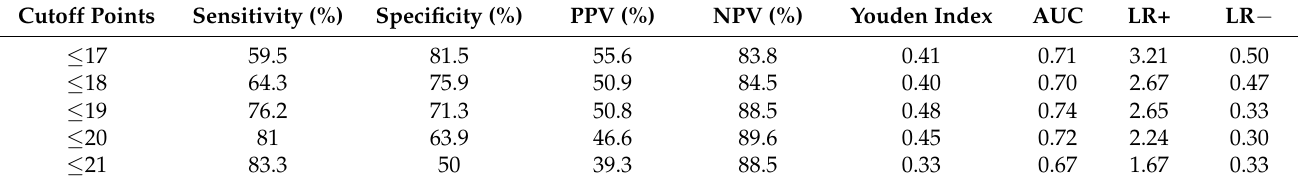
Table 3. The MoCA-Thai performance on screening for MCI at different cut-off points.